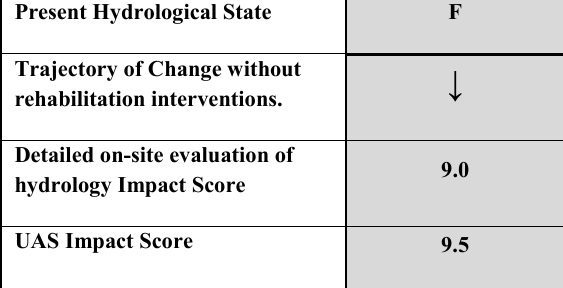
Table 3 Hydrological Health of the system and trajectory of